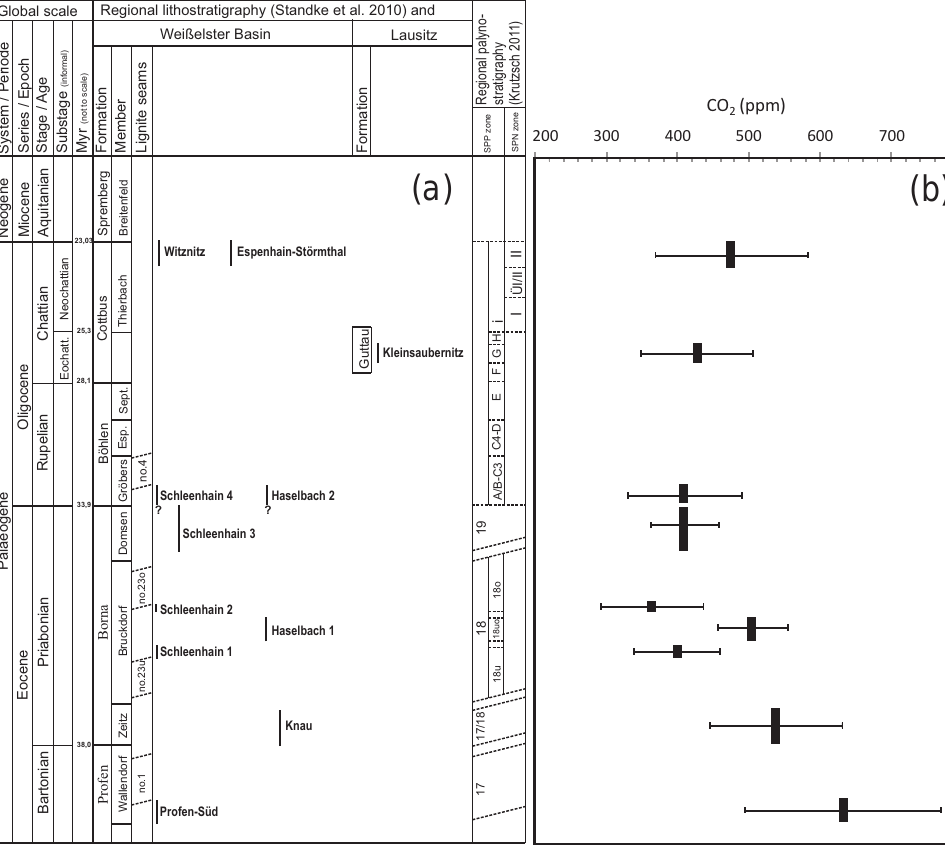
Figure 3. Stratigraphic position of the assemblages with Eotrigonobalanus furcinervis , regional lithostratigraphy and Krutzsch’s (2011) correlation to the spore-pollen zones including his proposed correlation of spore-pollen zones to global scale (see Sect. 2.2 for explanation and comments on dating uncertainty); black vertical bars next to assemblage names are the temporal uncertainty (based on a combination of lithostratigraphic information of the respective unit and spore-pollen zonation); bars of Schleenhain 1 and 2 are not to scale because gaps in the sediment deposition of the respective units are not equivalent to the duration of spore-pollen zones; gaps between the Eocene spore-pollen (sub-)zones illustrate gaps in the terrestrial sediment record, i.e. erosion. For horizon information see Table